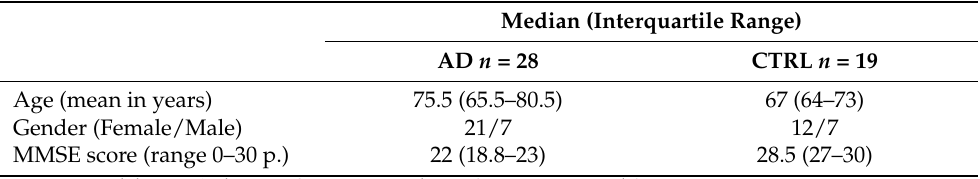
Table 1. Demographic data and characteristics of the study groups.